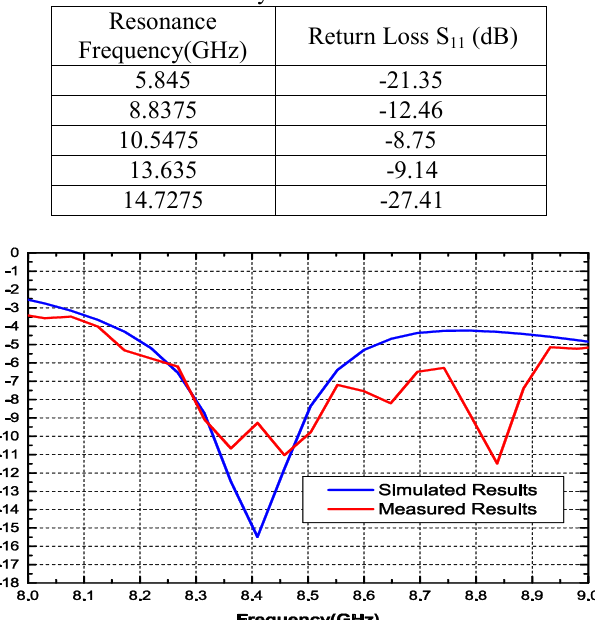
Table 3 Summary of the measured results